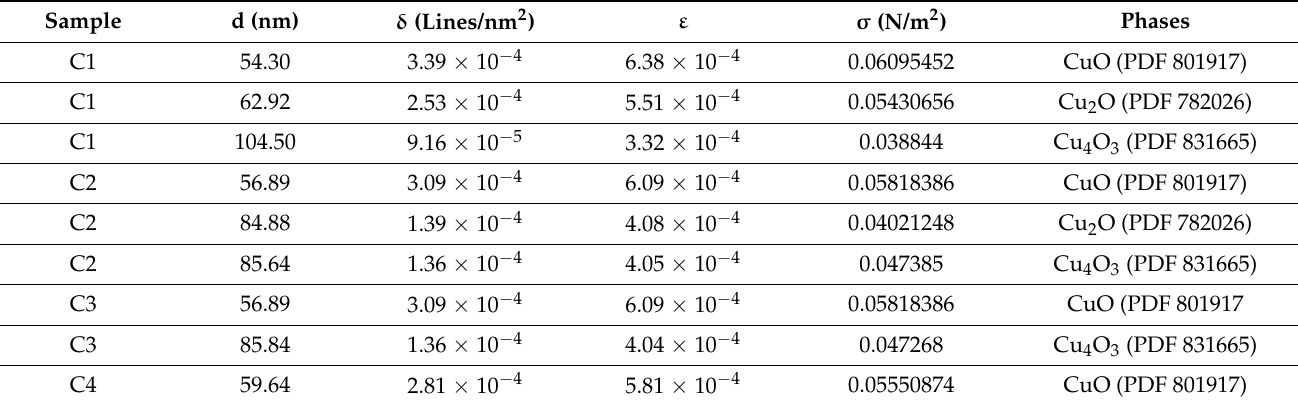
Table 4. CuO, Cu 2 O, and Cu 4 O 3 crystallites sizes, dislocations, stress, strain, and identified